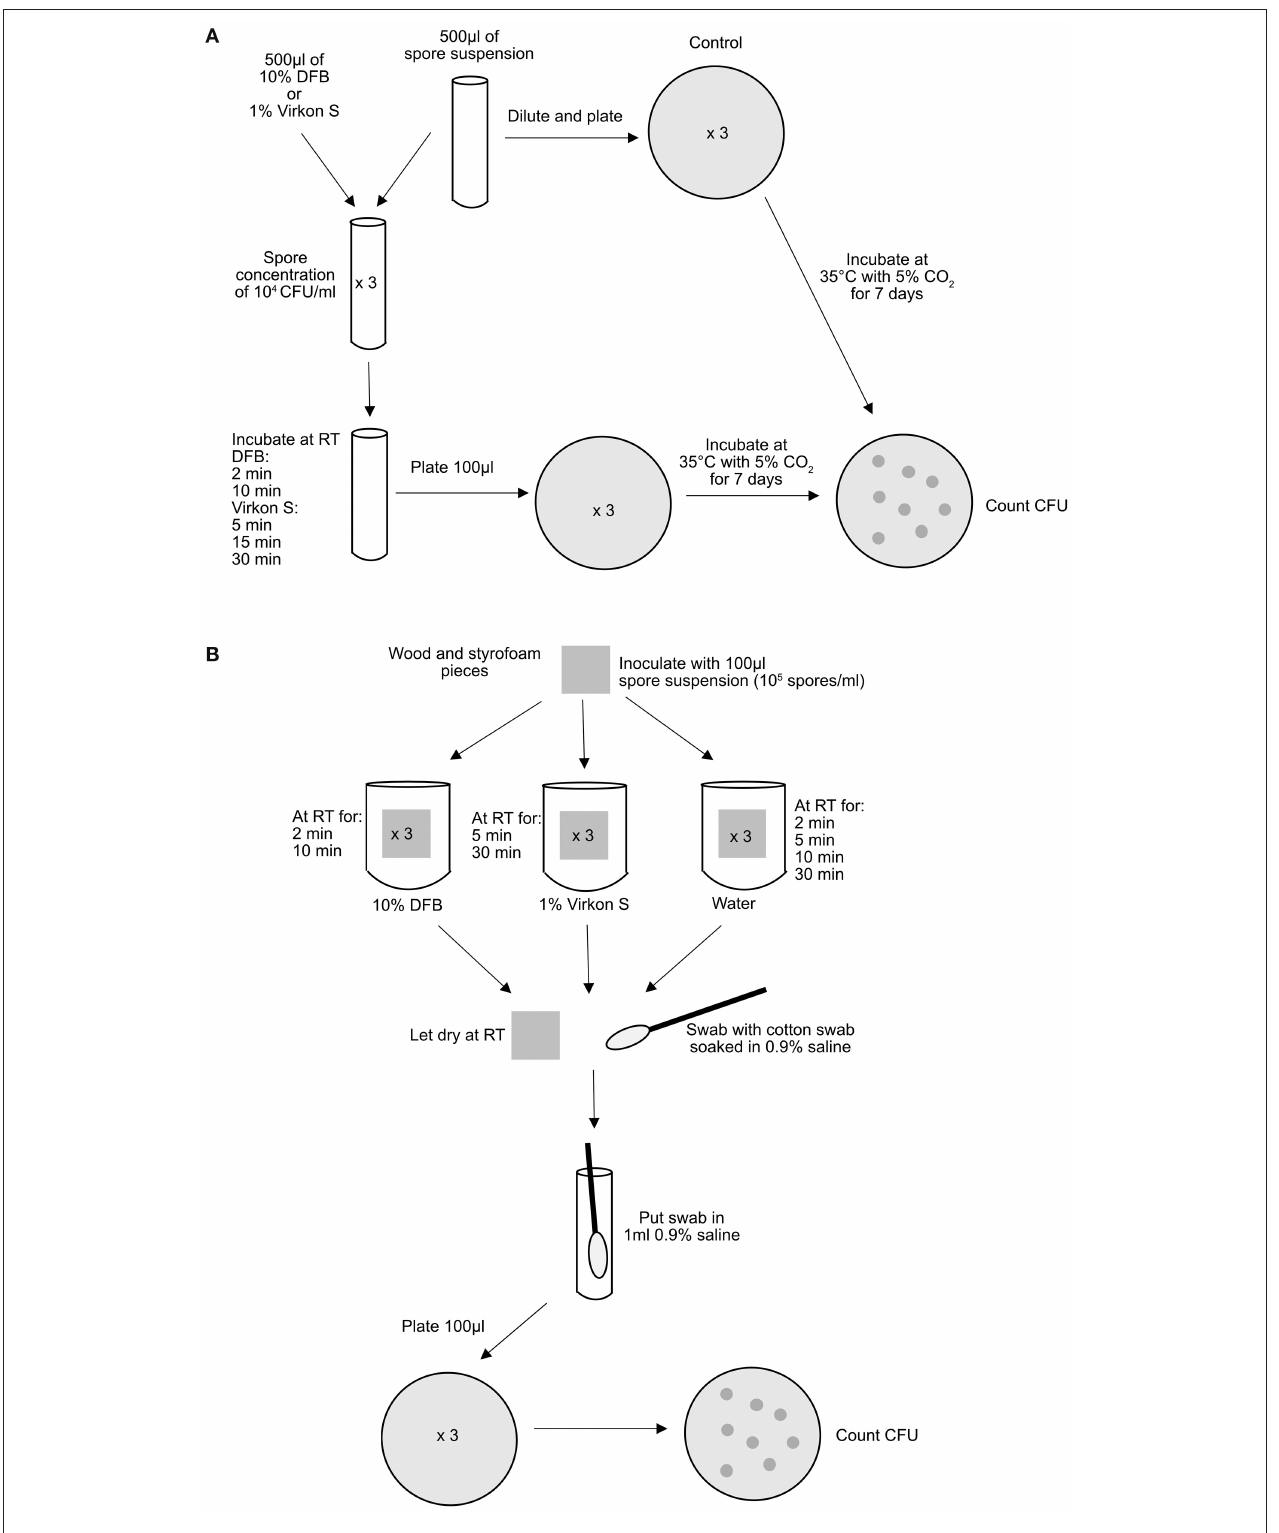
FIGURE 1 | Schematic description of the experimental setup. (A) in spore suspension and (B) on wood and Styrofoam. RT, room temperature.